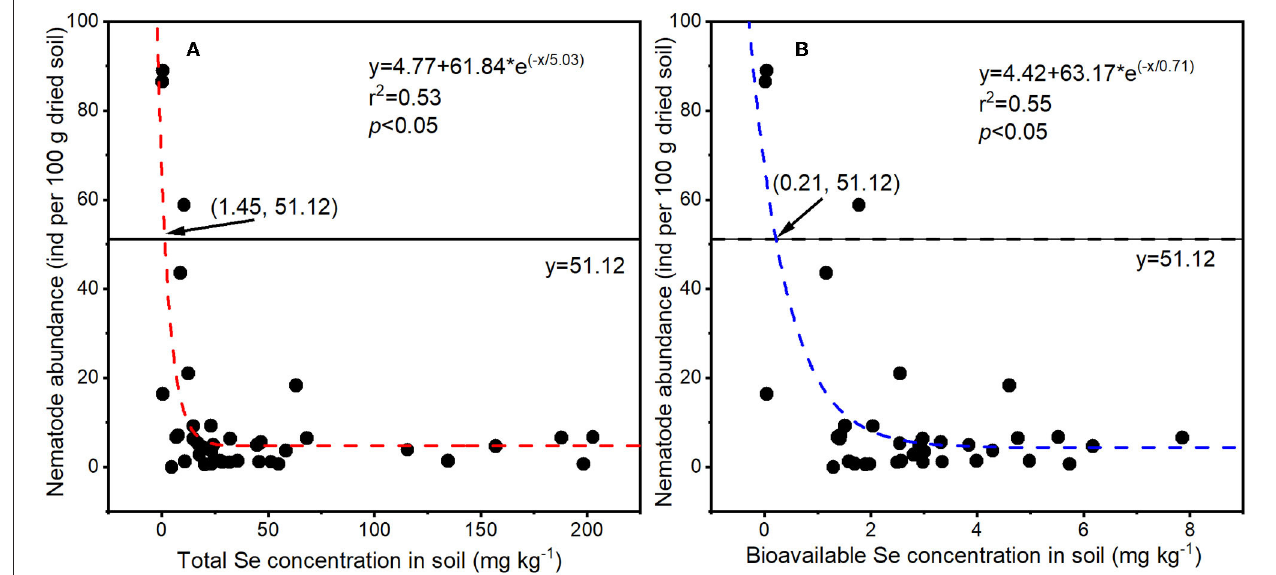
FIGURE 3 | Relationships between soil Se concentrations [total Se (A) and bioavailable Se (B) ] with nematode abundances ( n = 39). The straight y = 51.12 = 63.90 × 80%, 63.90 was the nematode abundance in CK soil, 51.12 was the nematode abundance corresponding to EC20, and 1.45 and 0.21 were EC20 for total Se and bioavailable Se in soil nematode